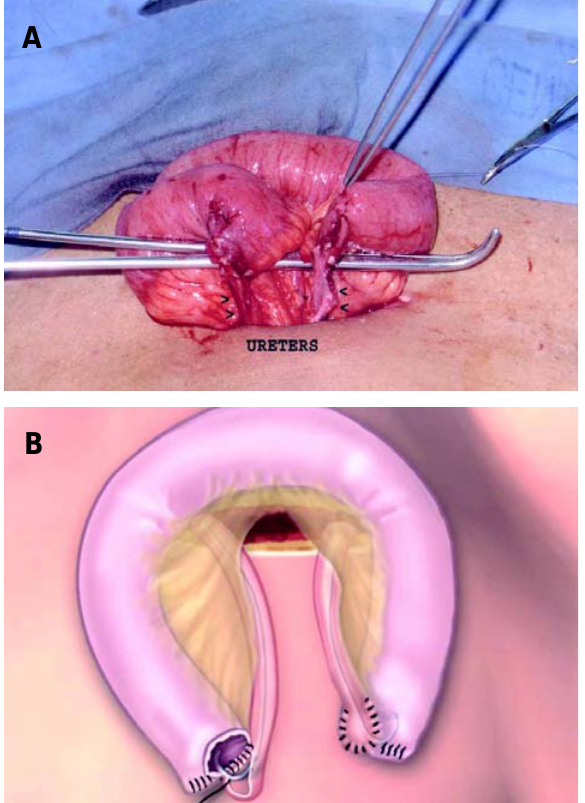
Figure 2 – A) Photograph showing the ureters (arrowheads) being directly anastomosed to the open ends of the limbs of the neobladder; B) Schematic